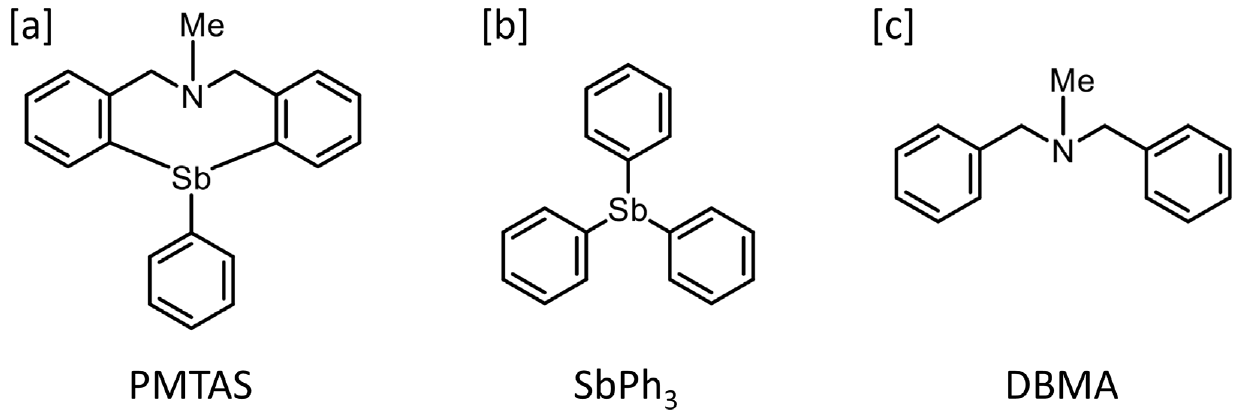
Figure 1. The structures of PMTAS ( a ); SbPh 3 ( b ); and DBMA ( c ). First, we examined whether PMTAS affects the accumulation of proteoglycans syn- thesized by vascular endothelial cells in the cell layer and conditioned medium. In our system, perlecan and biglycan are detected in both the cell layer and conditioned medium, while syndecans accumulates only in the cell layer [26,27]. The accumulation of [ 35 S]sulfate- labeled proteoglycans in the conditioned medium dose-dependently increased in a sig- nificant manner on treatment with PMTAS in both dense and sparse cultures of vascular endothelial cells (Figure 2A,B, respectively). However, in the case of vascular smooth mus- cle cells, PMTAS increased the accumulation of radiolabeled proteoglycans secreted into the conditioned medium only in the dense culture (Figure 2C,D). Proteoglycan accumulation in the cell layer was unaffected by treatment with PMTAS in both vascular endothelial and smooth muscle cells with high or low cell densities. Additionally, the amount of radiolabeled proteoglycans secreted by vascular endothelial cells increased between 24 and 72 h following PMTAS treatment (Figure